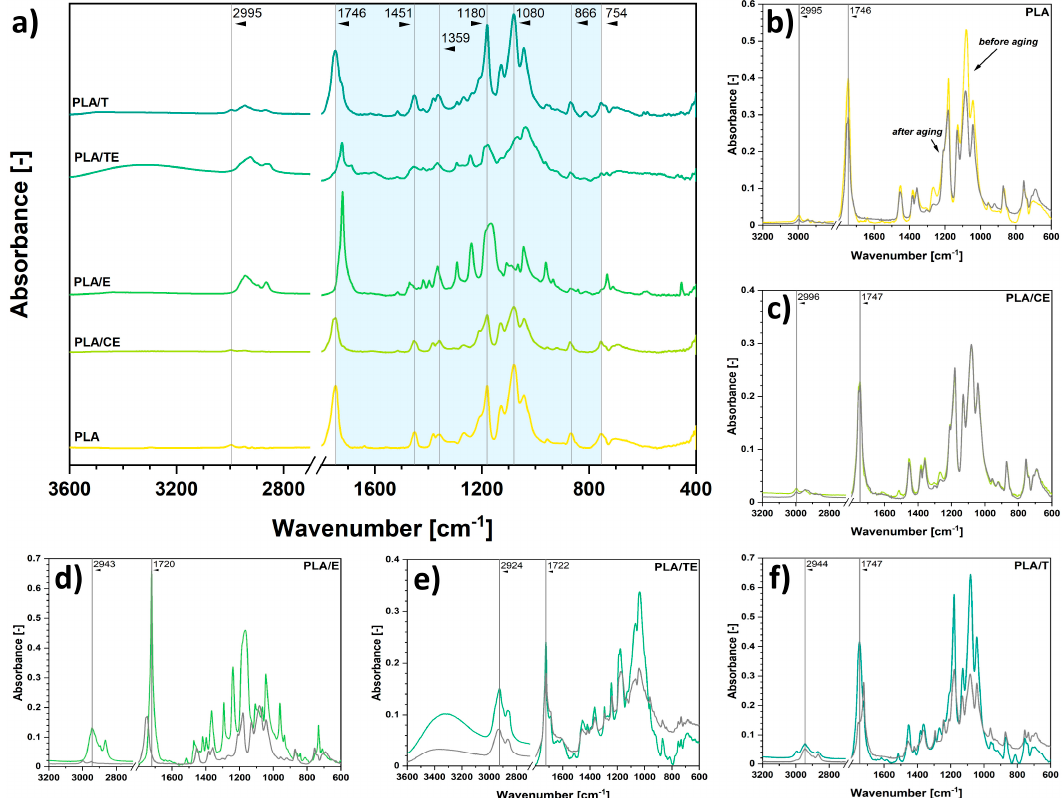
Figure 3. Fourier-transform infrared spectra for the impregnated samples of poly(lactic acid) (PLA) ( a ) and representation of the changes observed after the aging process for neat PLA ( b ) and PLA impregnated with clove extract ( c ), eugenol ( d ), thyme extract ( e ), thymol ( f ). Samples were subjected to 100 h of solar aging.